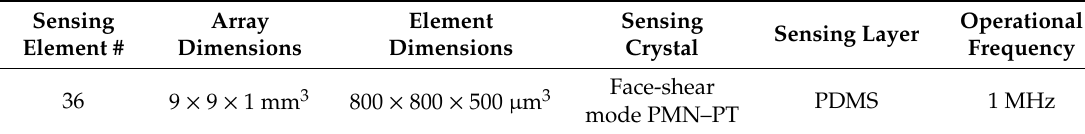
Table 1. Specification for the fabricated 6 × 6 sensor